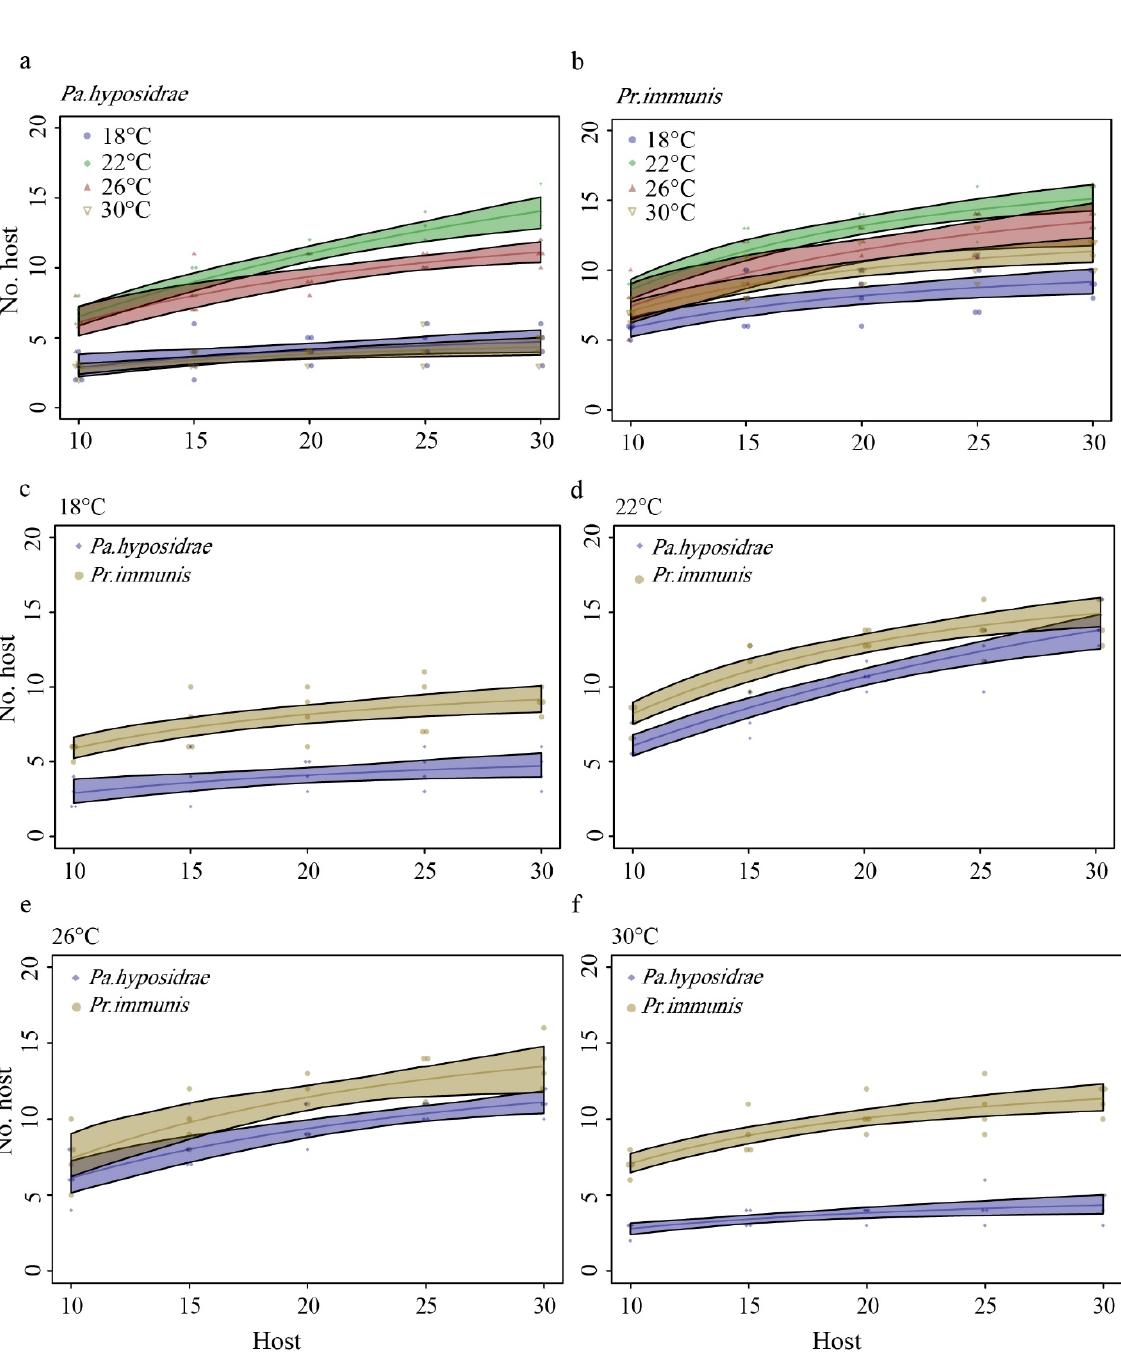
Figure 1. Functional responses of Pa. hyposidrae and P. immunis at five densities of E. grisescens under four temperatures. ( a ) Pa. hyposidrae , ( b ) Pr. immunis , ( c ) 18 °C, ( d ) 22 °C, ( e ) 26 °C, ( f ) 30 °C. Legends represent the observed values at four temperatures, x-axis represents the number of hosts, and y-axis represents the number of parasitized hosts. Curves show the predicted values based on Roger’s equation. Shaded areas are bootstrapped 95% confidence.